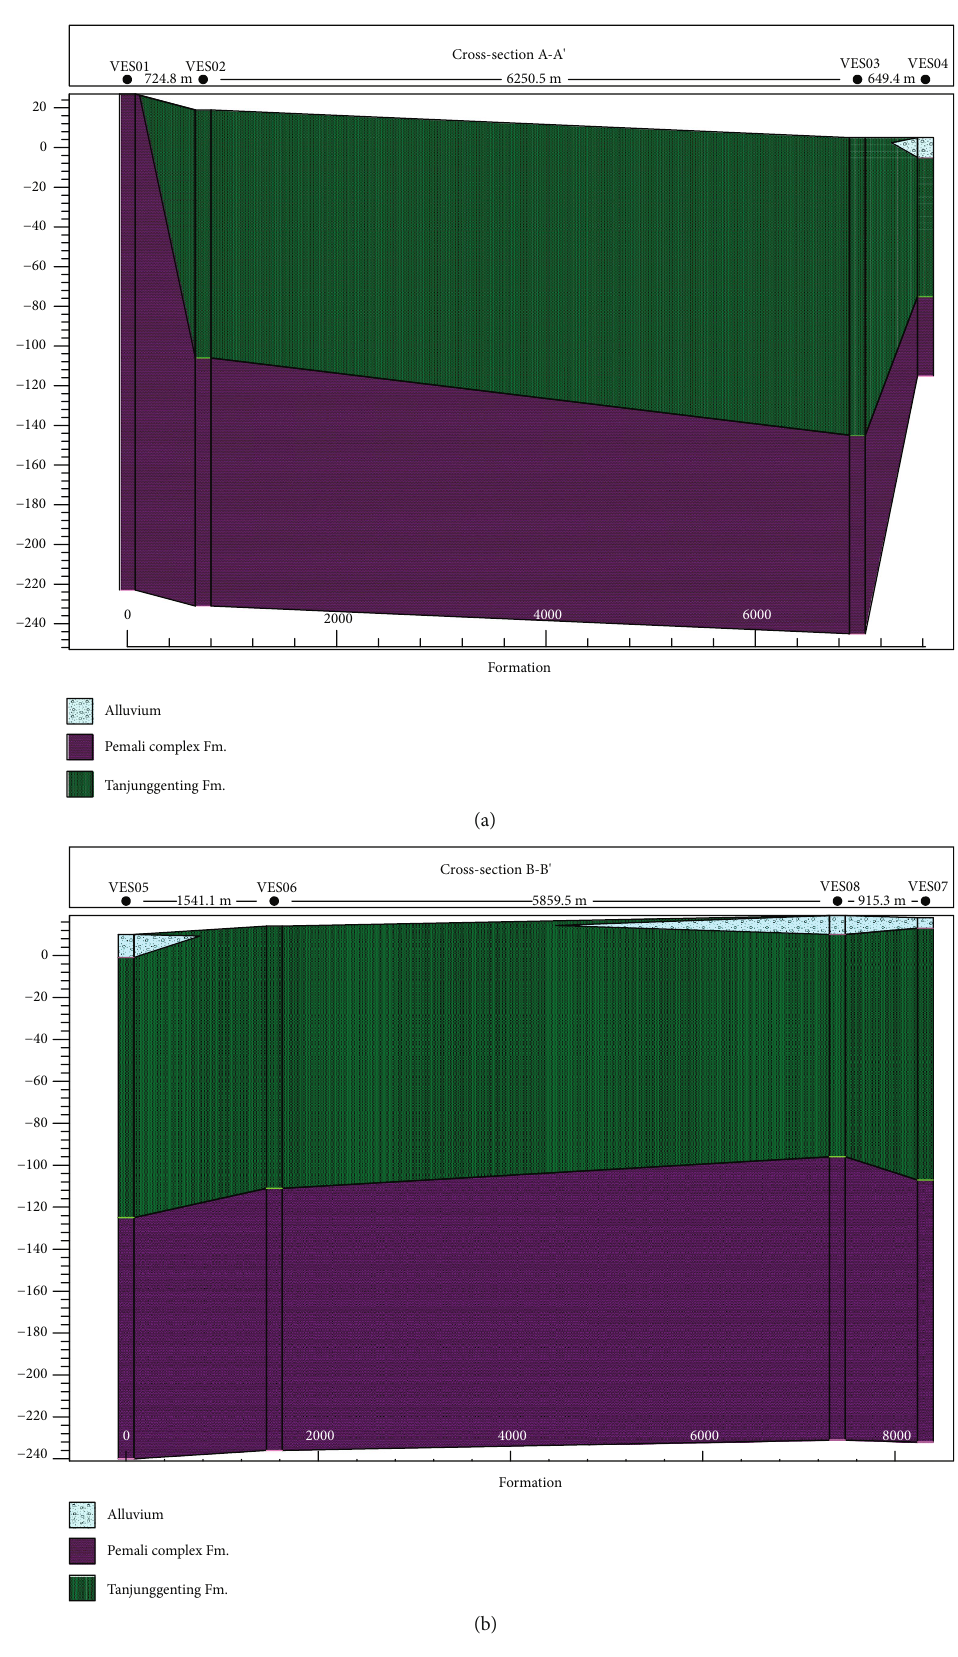
Figure 7: Cross-section from VES